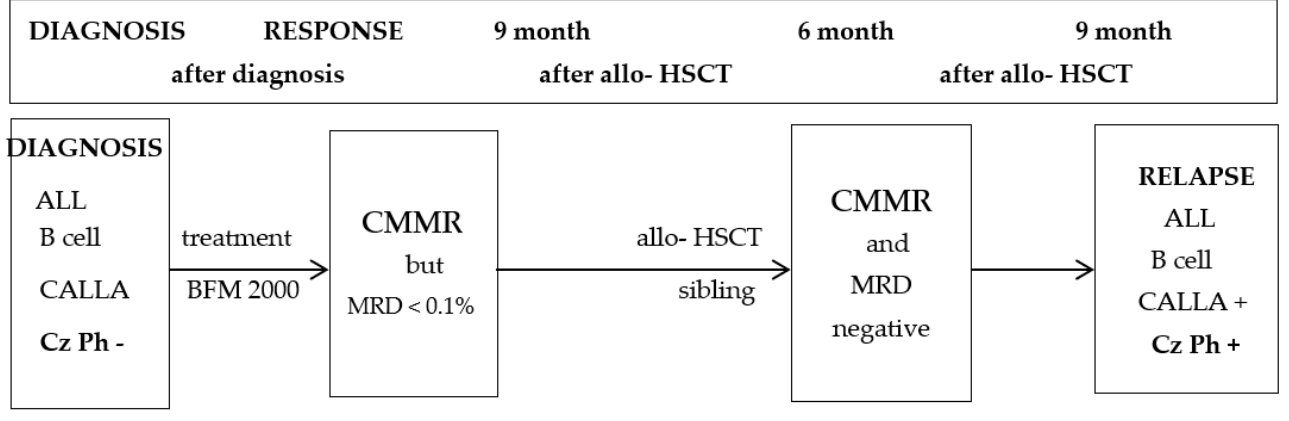
Figure 1. Evolution of disease. CMMR = complete medullary morphological remission; MRD = minimum residual disease; Allo-HSCT = allogeneic hematopoietic stem cell transplanta- tion; Cz Ph = Philadelphia